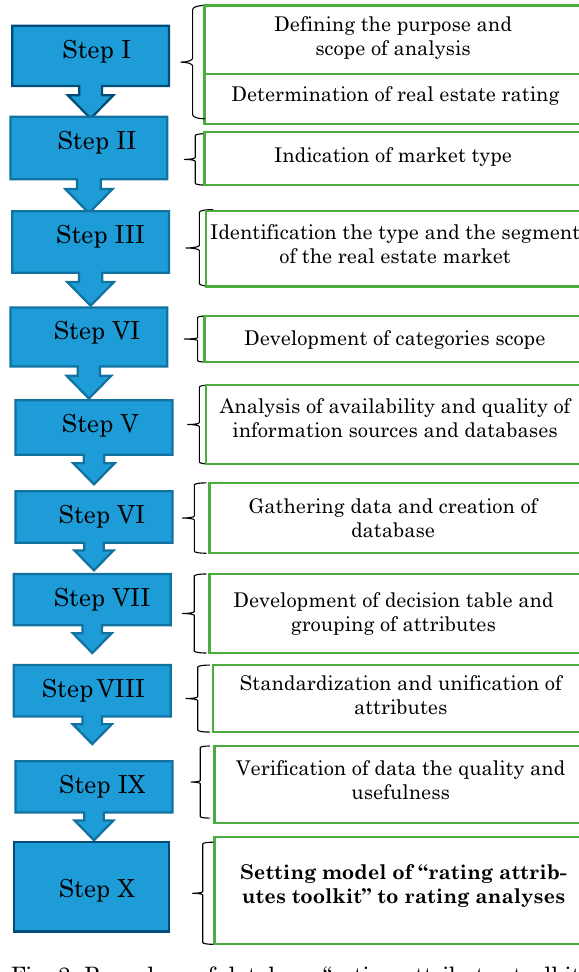
Fig. 2. Procedure of database “rating attributes toolkit” elaboration Source : own study.